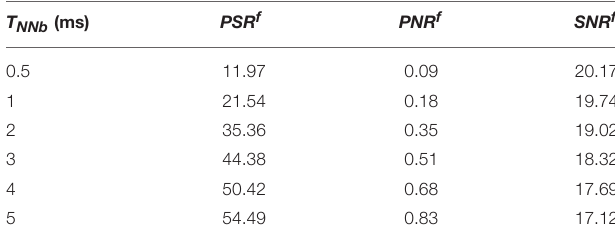
TABLE 4 | Effect of varying parameter T NNb in the NNb filter on Filtering